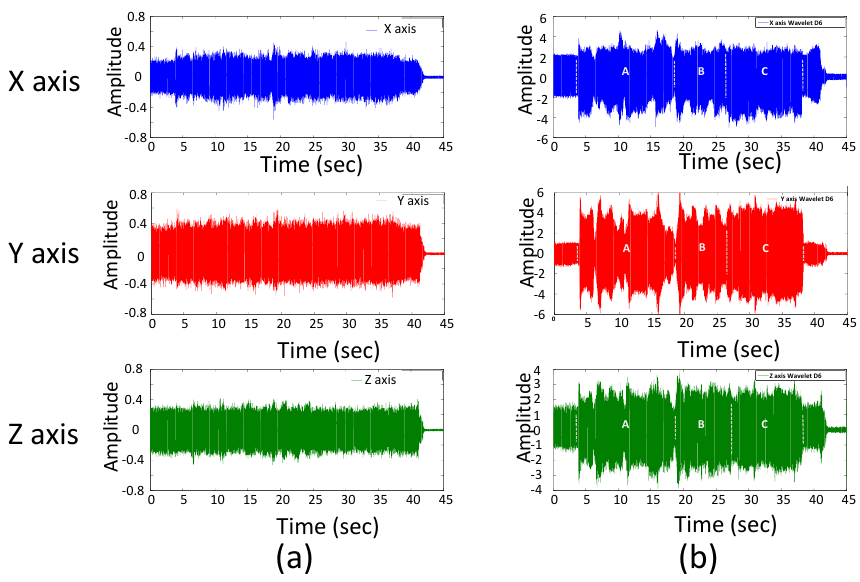
Figure 7. Time domain vibration signal with a worn tool: ( a ) raw signal; ( b ) wavelet coefficient (30 um).